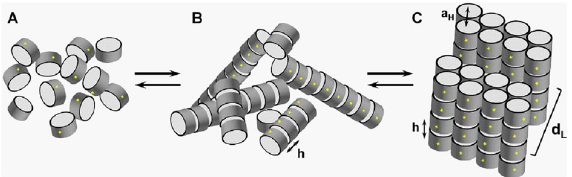
Figure 8. Schematic presentation of different nucleosome/chromatosome phases. ( A ). Isotropic solution with repulsive interaction between the particles. ( B ). Columnar phase without inter-columnar order. The stacking distance, h, characterises the separation between nucleosomes or chromatosomes within the column. ( C ). The lamella-columnar phase observed for the 177 bp chromatosome; a H is an inter-columnar distance within a bilayer; d L is the distance between bilayers. The yellow dots indicate the facing direction of the nucleosome dyad or location of linker DNA in the chromatosome. Adapted from 61 with permission from